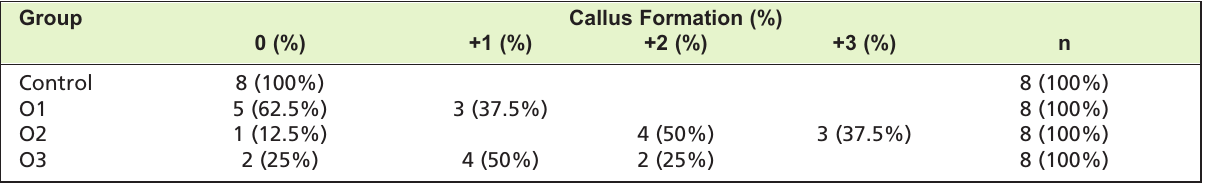
Callus formation in each group Table I: